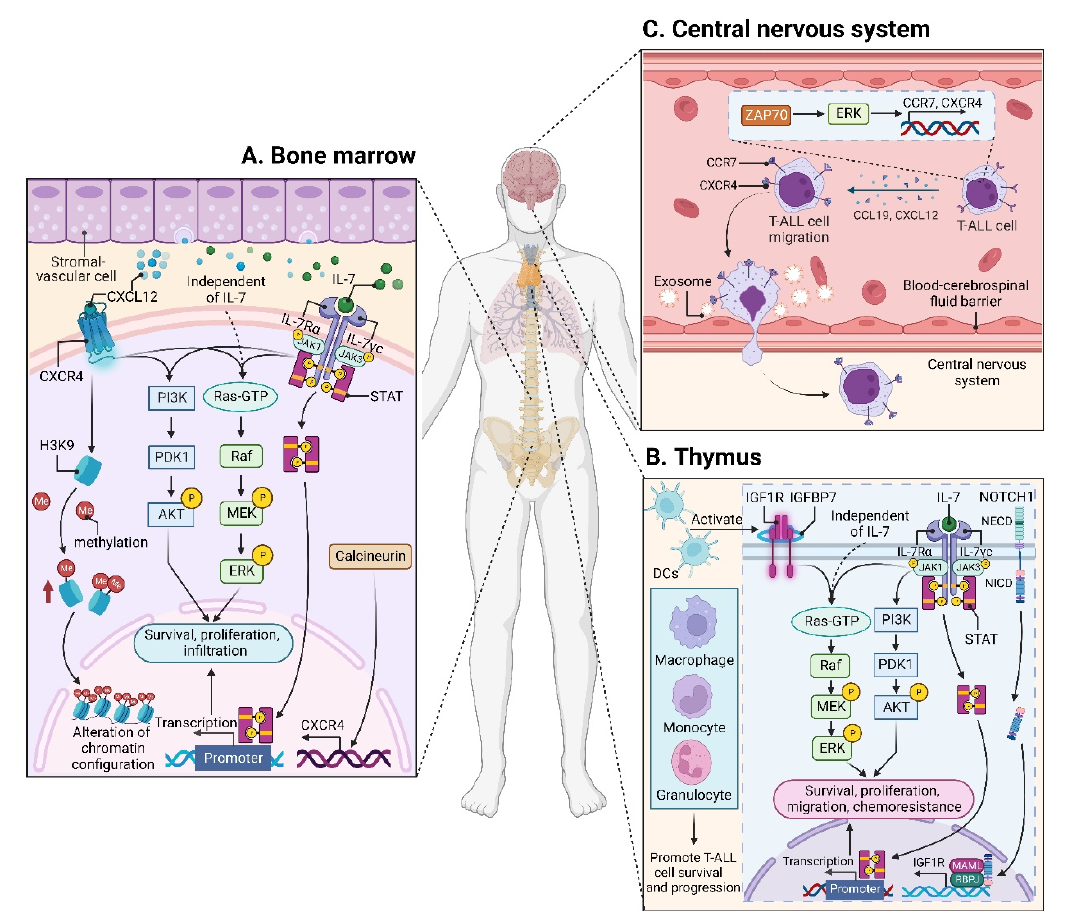
Figure 2. Microenvironments in T-ALL. ( A ) The interaction between CXCL12 and CXCR4 within the BM niche leads to activation of many signaling cascades, including PI3K-AKT and MEK-ERK pathways in T-ALL cells. CXCR12 also plays an epigenetic role by promoting H3K9 methylation in T-ALL cells. IL7 is produced by stromal cells in the BM ( A ) and thymus ( B ), facilitating the activation of JAK-STAT, PI3K-AKT, and MEK-ERK pathways in either an IL7-dependent or IL7-independent manner. ( B ) In the thymus, the high levels of IGF1R are supported by the activated NOTCH1 sig- naling. DCs support T-ALL growth via activating IGF1R and its downstream MAPK signaling; other myeloid cells including macrophages, monocytes, and granulocytes also support T-ALL sur- vival and progression. In addition to IGF1R, IGFBP7, which binds to IGF1R, contributes to T-ALL by prolonging IGF1R activation. ( C ) The CCL19/CCR7 signaling is necessary and sufficient for CNS infiltration in T-ALL. Additionally, ZAP70-ERK-induced upregulation of CCR7 and CXCR4, as well as the exosomes isolated from T-ALL cells also confer an increased risk for CNS involvement. BM, bone marrow; CCL19, CC chemokine ligand 19; CCR7, CC chemokine receptor7; CNS, central nerv- ous system; CXCL12, CXC chemokine ligand 12; CXCR4, CXC chemokine receptor 4; DCs, dendritic cells; ERK, extracellular regulated protein kinase; H3K9, histone 3 lysine 9; IGF1R, insulin-like growth factor 1 receptor; IGFBP7, insulin-like growth factor binding protein 7; IL7, interleukin 7; JAK, Janus kinase; MAPK, mitogen-activated protein kinase; MEK, MAPK kinase; STAT, signal transducer and activator of transcription; ZAP70, zeta-chain-associated protein kinase 70.